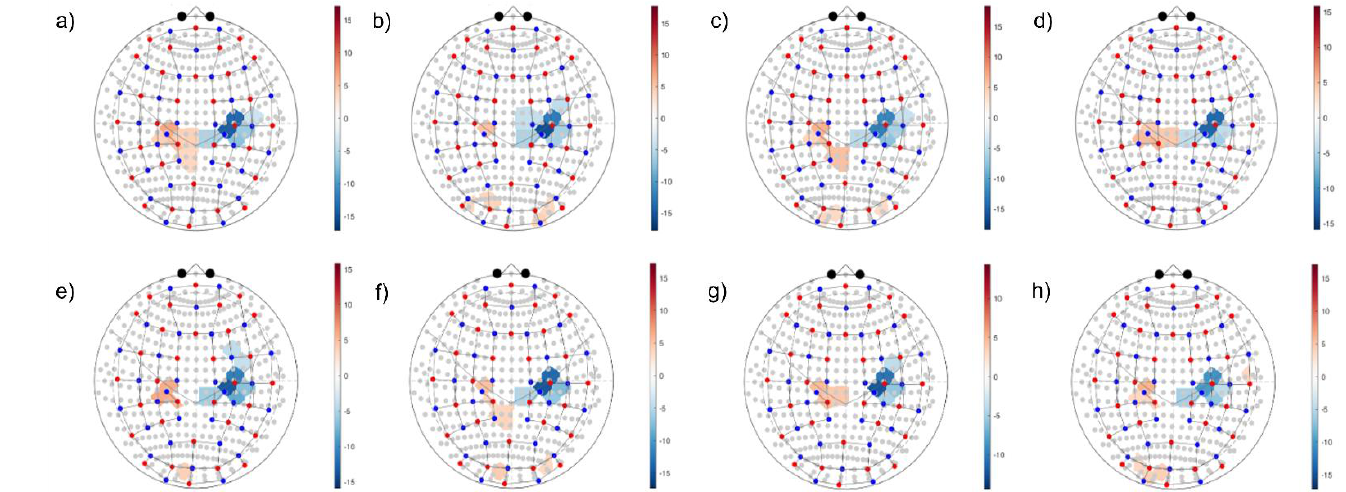
Figure 11. Second-level activation vs. resting condition statistical maps related to the left-hand motor grasp of ∆ [ HbR ] . Colorbars indicate significant t -values corrected for multiple comparisons ( p FDR < 0.05). Positive t-values indicate locations where the mean of ∆ [ HbR ] activation was signifi- cantly higher than that in the resting condition, and conversely for negative values. ( a ) SC-MARA- spline, ( b ) MC-MARA-spline, ( c ) SC-MARA-tPCA, ( d ) MC-MARA-tPCA, ( e ) HybridMARA-spline SG, ( f ) HybridMARA-tPCA SG, ( g ) TDDR, and ( h ) Wavelet method.